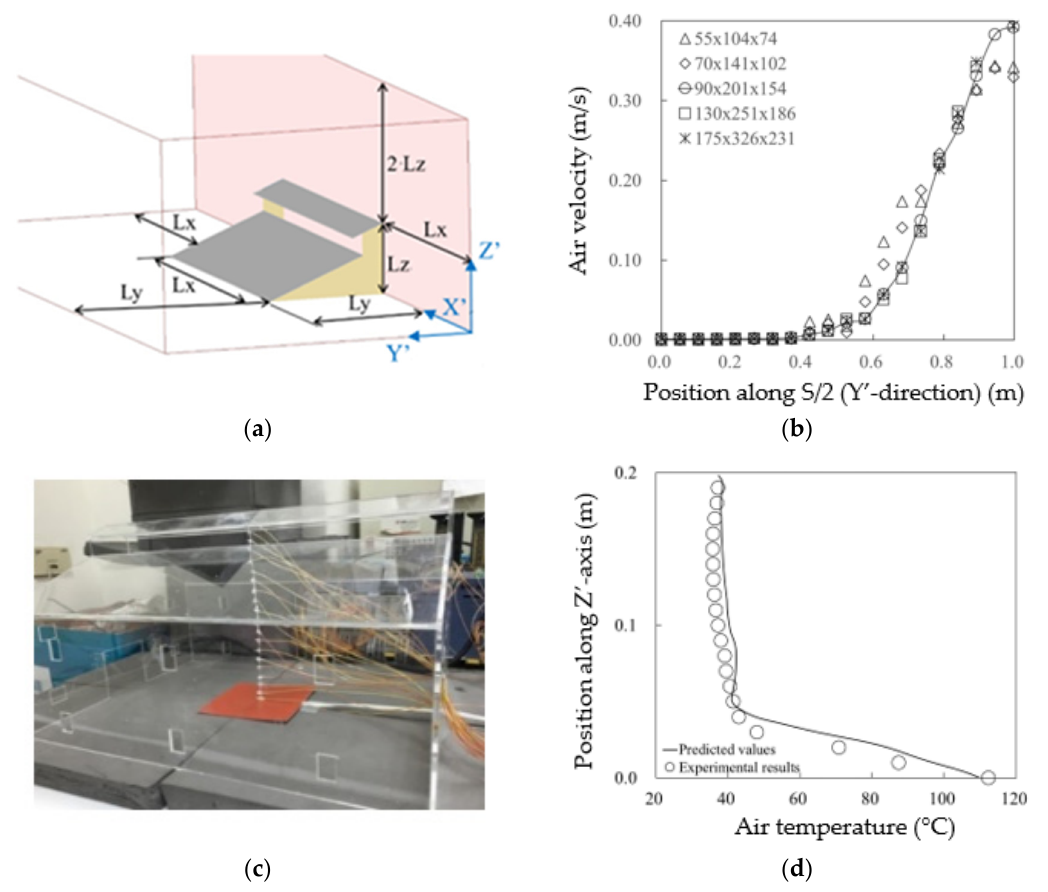
Figure 3. ( a ) The computational domain; ( b ) grid independency test results; ( c ) experimental model for numerical validation; ( d ) validation results.